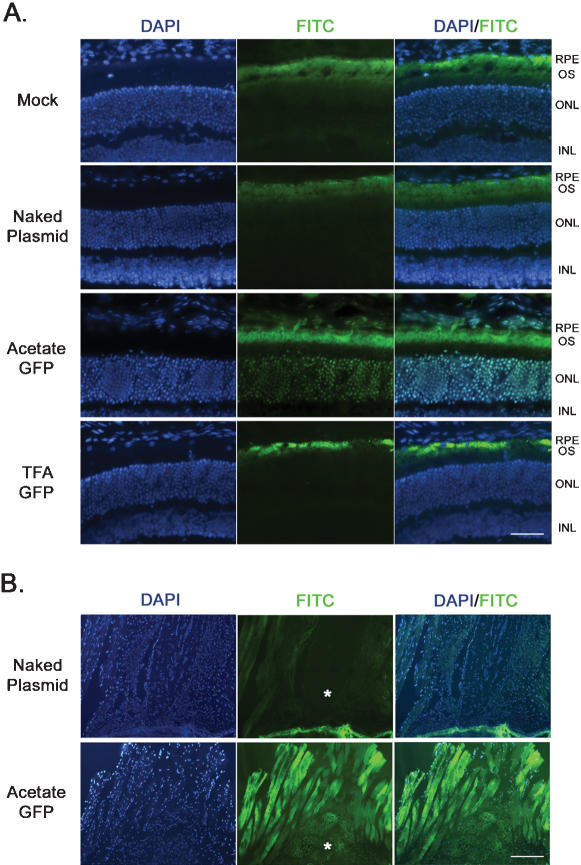
EGFP localization in ocular tissues following subretinal injection.Direct fluorescence microscopy was utilized to localize EGFP expression in ocular tissues at 2-days post-injection of 0.6 µg of compacted DNA.(A) EGFP fluorescence was detected in the ONL and RPE of eyes injected with the AC-GFP and TFA-GFP nanoparticles, respectively.(B) EGFP was also detected within the optic nerve (asterisks) and the extraocular muscles following injection of the AC-GFP nanoparticle.Scale bars, 10 µM.